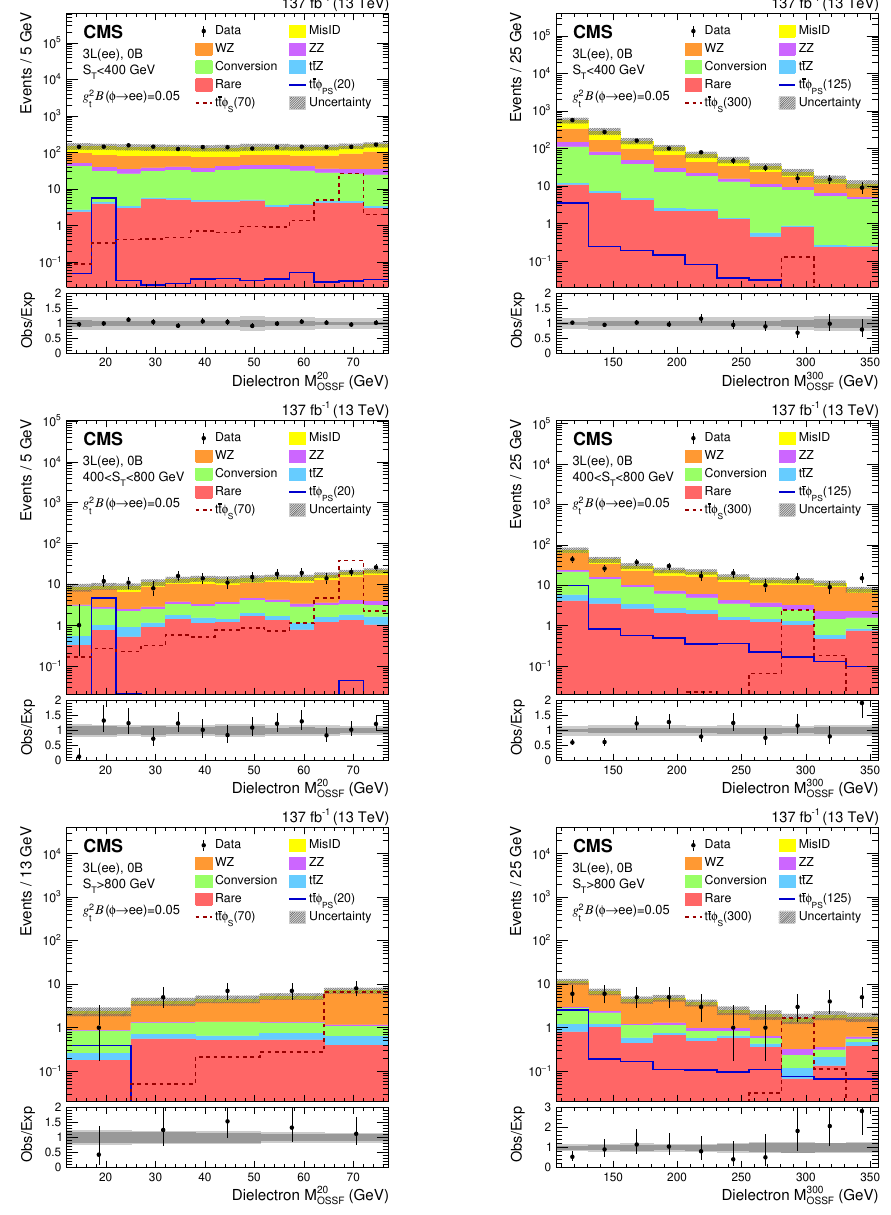
Figure 5 . Dielectron M 20 (left column) and M 300 (right column) distributions in the 3L(ee) OSSF OSSF 0B tt (cid:30) signal regions. Upper, center, and lower plots are for S < 400 GeV, 400 < S < 800 GeV, T T and S > 800 GeV, respectively. The total SM background is shown as a stacked histogram of all T contributing processes. The predictions for tt (cid:30) ( ! ee) models with a pseudoscalar (scalar) (cid:30) of 20 B ( (cid:30) ! ee) = 0 : 05 are also shown. The lower panels and 125 (70 and 300) GeV mass assuming g 2 t show the ratio of observed to expected events. The hatched gray bands in the upper panels and the light gray bands in the lower panels represent the total (systematic and statistical) uncertainty of the backgrounds in each bin, whereas the dark gray bands in the lower panels represent only the statistical uncertainty of the backgrounds. The rightmost bins do not contain the over(cid:13)ow